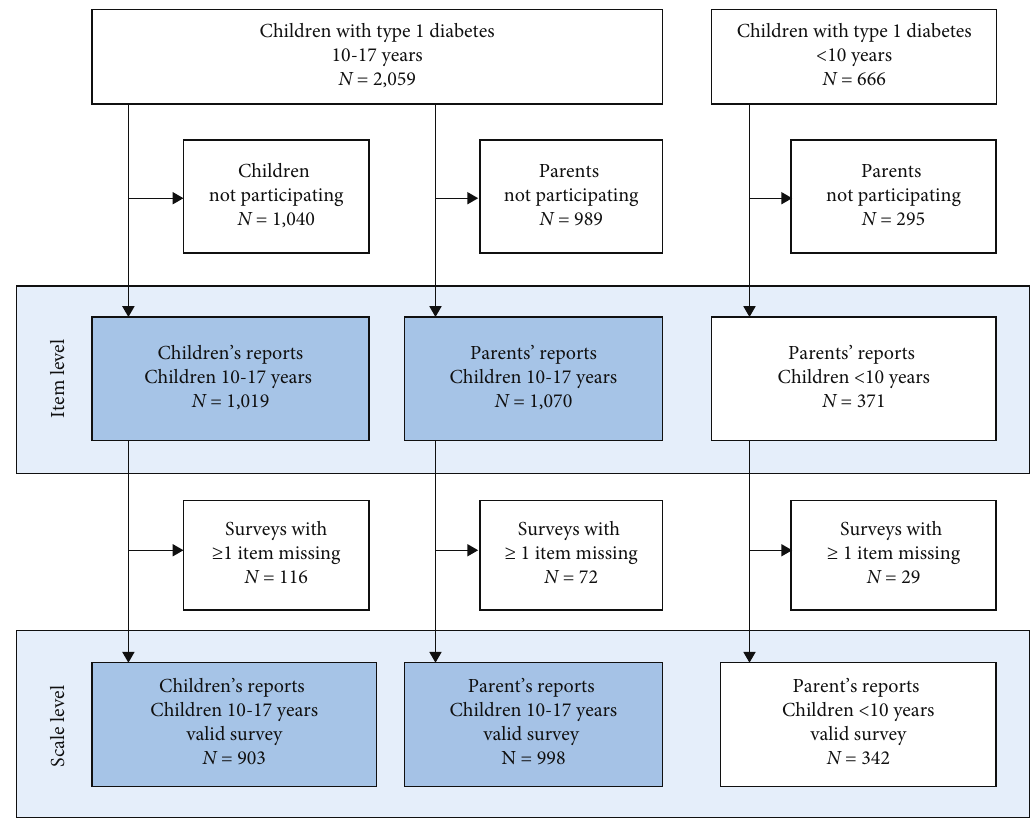
Figure 1: Flowchart of the sampling process. For statistics on item level, surveys from all participants were used ( N = 1,019 + N = 1,070 + N = 371 ). For scales based on sum scores, we used only completed surveys (valid surveys, N = 903 + N = 998 + N = 342 ). When comparing children ’ s and parents ’ responses, we only used responses from the same age group (marked in blue, 10-17